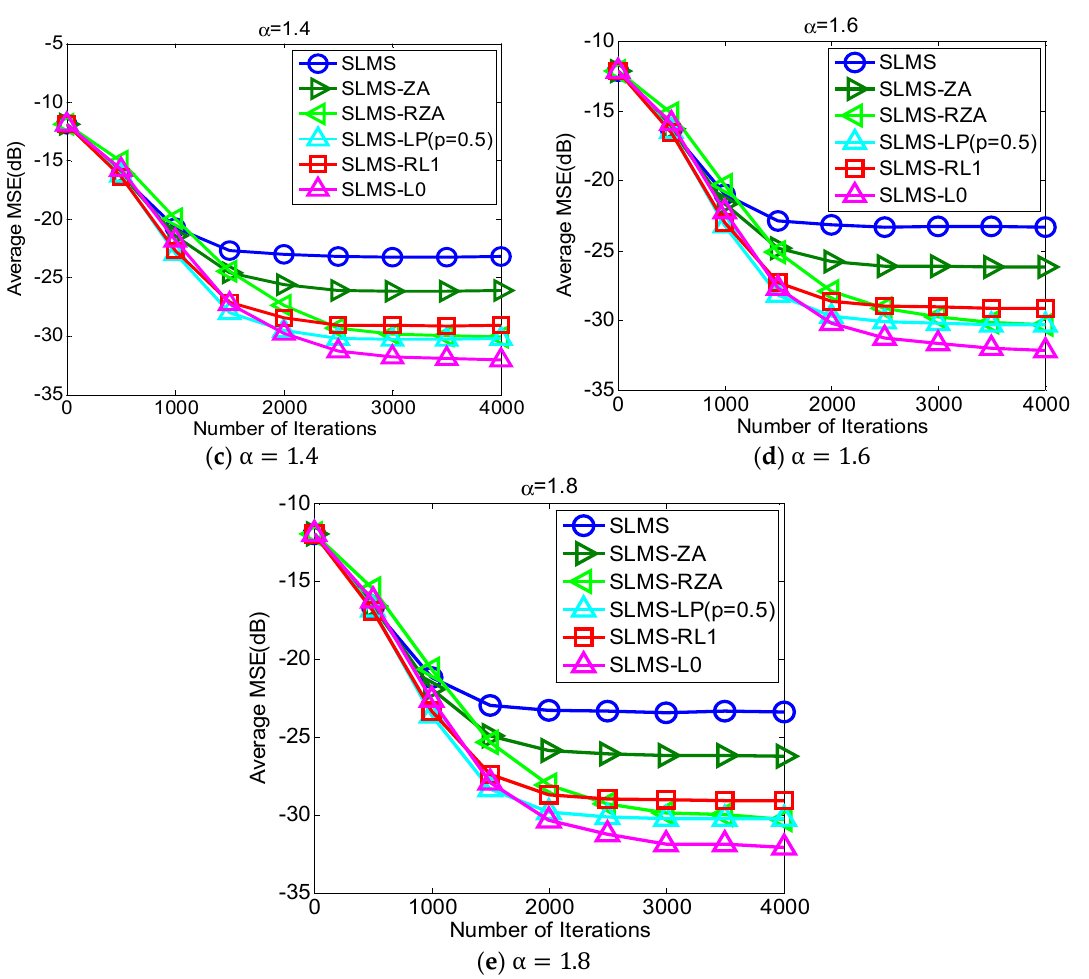
Figure 2. Monte Carlo based MSE curves averaging over 1000 runs with respect to different characteristic exponents α ∈ { 1.0, 1.2, 1.4, 1.6, 1.8 } , in scenarios of dispersion parameter γ = 1.0, channel sparsity K = 8, channel length N = 128, and SNR = 10